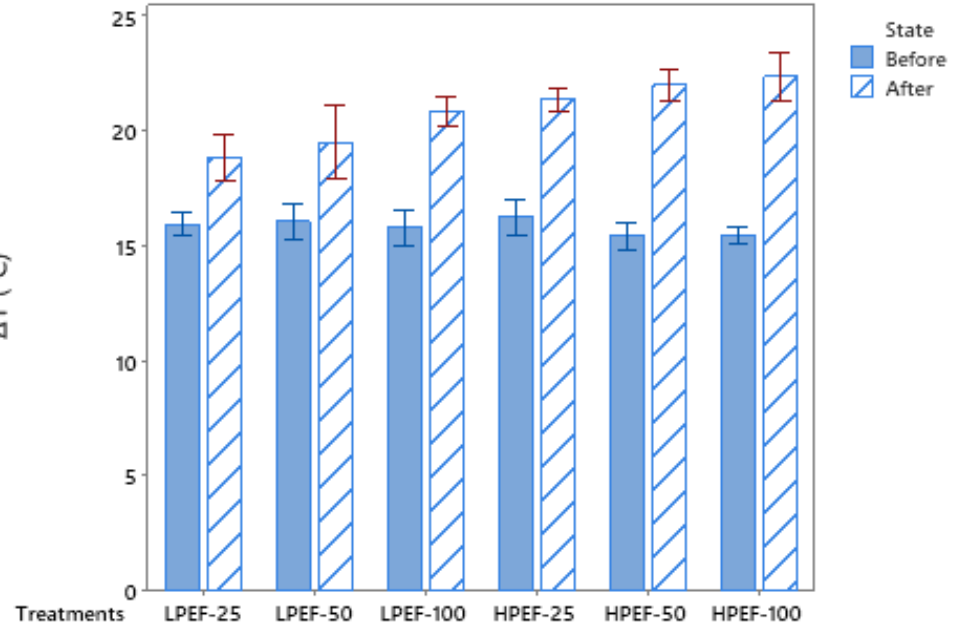
Figure 2. Effect of different pulsed electric field treatments on temperature change ΔT (°C) of chicken meat samples.